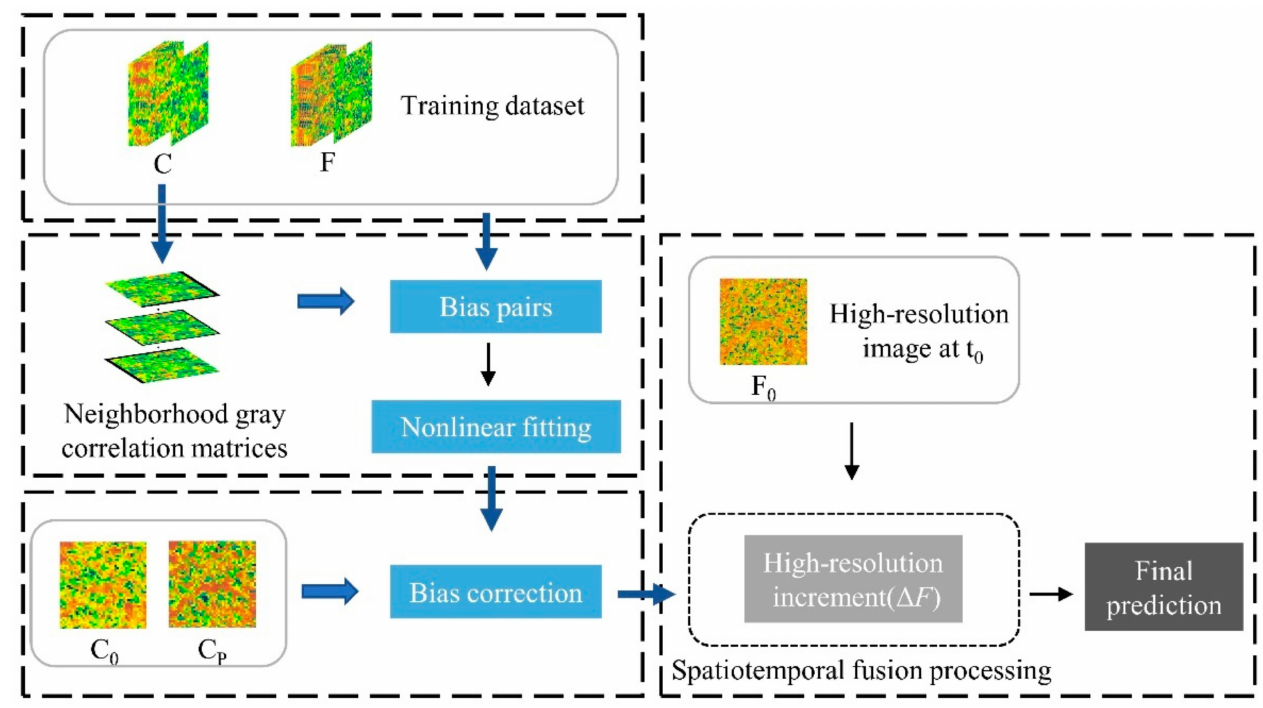
Figure 1. Flowchart of the sensor bias correction method applied in this study. C is the low-spatial- resolution dataset, F represents the high-spatial-resolution dataset, C 0 is the low-spatial-resolution image of the base date (t 0 ), and C p represents the high-spatial-resolution image of the predicted date (t p